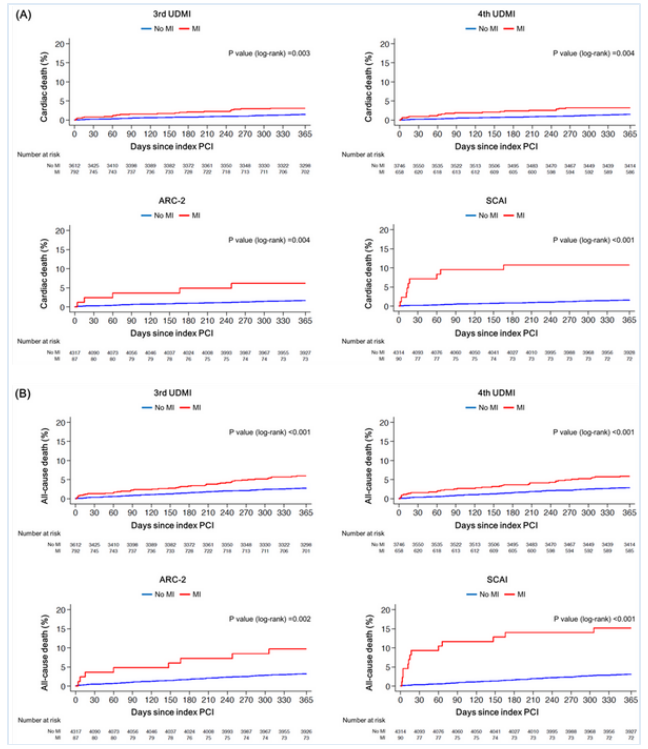
Figure 2. Kaplan-Meier cumulative event curves for cardiac death (A) and all-cause death (B).